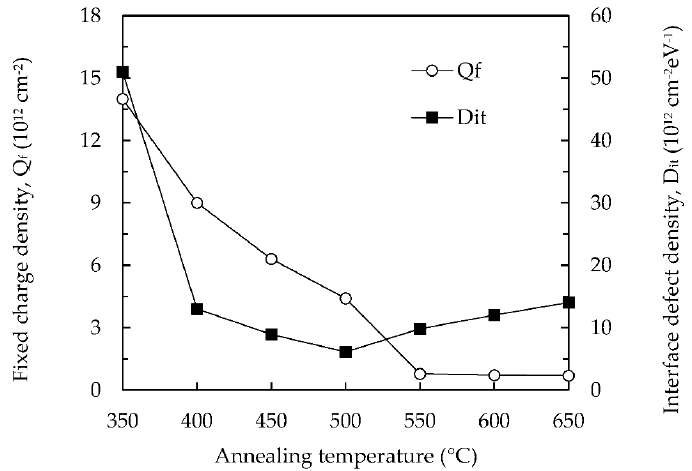
Figure 3. Fixed charge density ( Q f ) and interface defect density ( D it ) of the HfO 2 -passivated Si wafers with different annealing temperatures. Table 1. Low- and high-injection-level minority carrier lifetime and their ratios for the HfO 2 -passivated silicon wafers at different annealing temperatures.